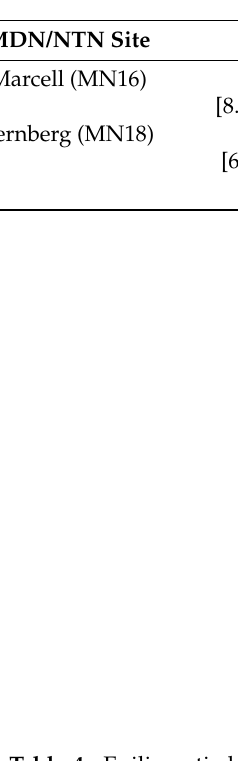
Table 4. Epilimnetic lake water trends in methylmercury (MeHg aq ), total mercury (THg aq ), and sulfate, from locally weighted regression analysis, for the period 2001–2018. (EV 2001 and EV 2018 are expected values for concentrations of MeHg aq and THg aq , in ng L − 1 ; and sulfate, in mg L − 1 , from locally weighted regression analysis, for 1 July 2001, and 1 July 2018, respectively. % change, percentage change in expected values from 2001–2018. Lower and upper 95-percent confidence limits shown in